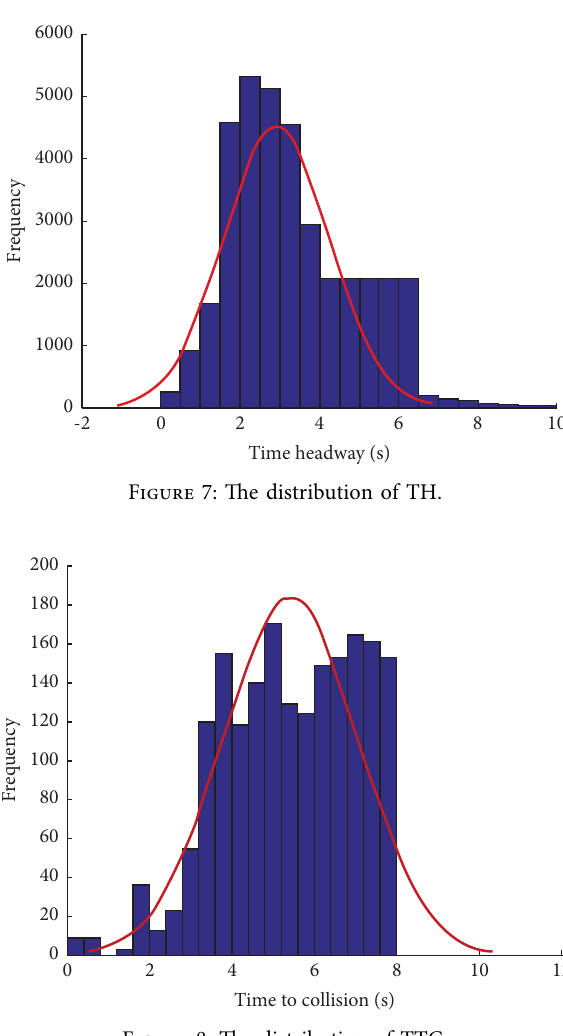
Figure 8: Te distribution of TTC.